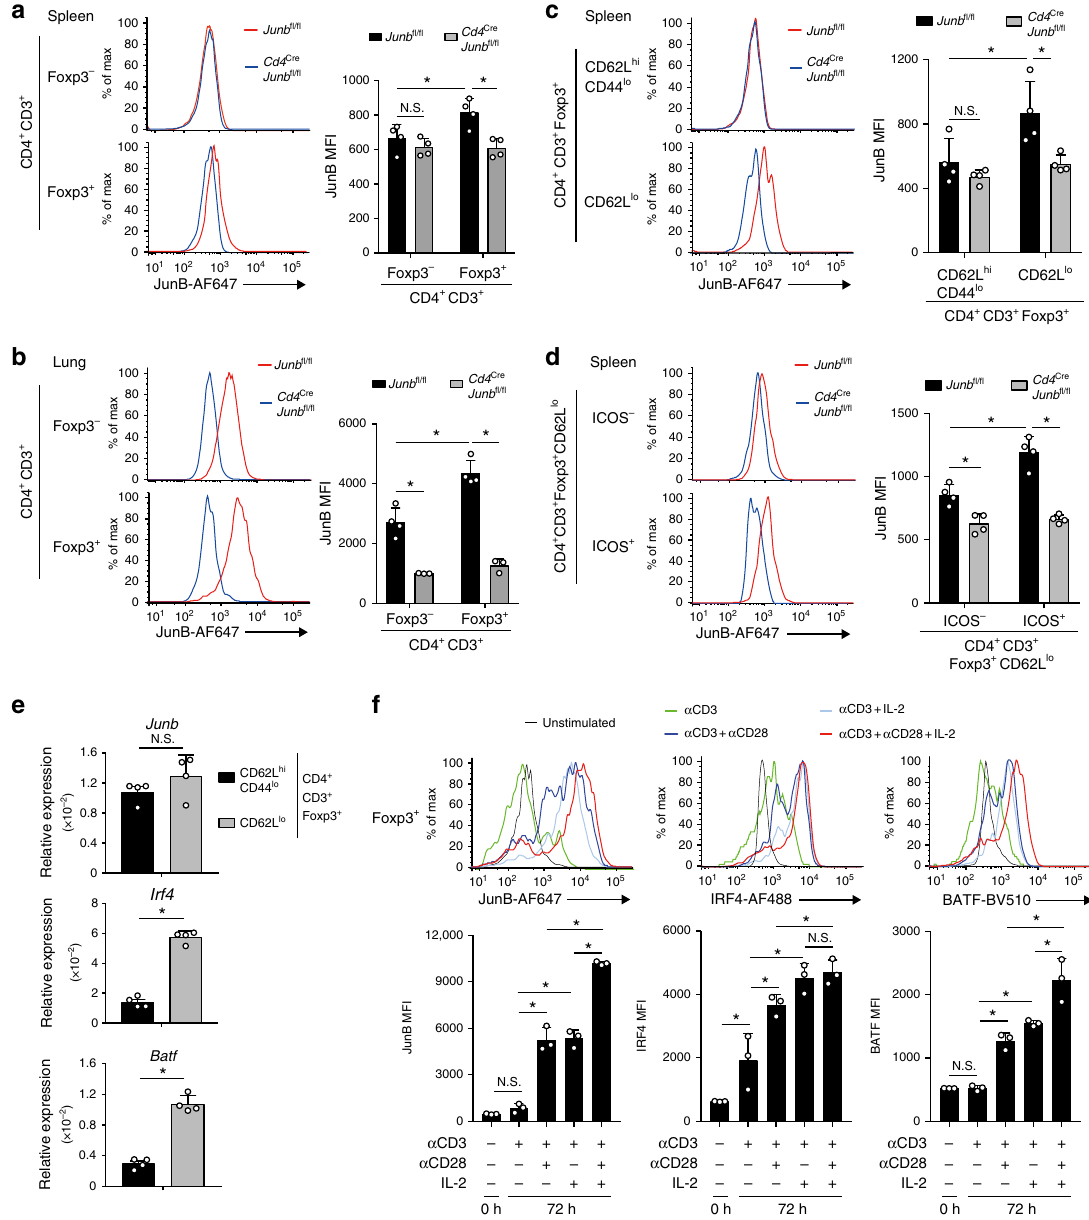
Fig. 1 Expression of JunB is upregulated in eTreg cells. a – d Flow cytometry analysis of JunB in Foxp3 + (Treg) or Foxp3 − (Tconv) cells isolated from spleen a and lung b , Treg cells bearing CD62L hi CD44 lo phenotypes (cTreg) or CD62L lo phenotypes (eTreg) c , and ICOS + or ICOS − eTreg cells d isolated from spleen of wild-type C57BL/6 mice (7 – 10-week-old). Cd4 cre Junb fl / fl mice were used as negative controls. e CD62L hi CD44 lo cTreg and CD62L lo eTreg cells were sorted by FACS, and Junb mRNA expression was analyzed by qRT-PCR. a – e Error bars indicate s.d. ( n = 4). * P < 0.05; N.S., not signi fi cant (unpaired two-tailed Student ’ s t test). MFI, mean fl uorescence intensity. f JunB expression was analyzed by fl ow cytometry in CD4 + CD25 + Treg cells activated with indicated stimuli for 72 h. Error bars indicate s.d. ( n = 3). * P < 0.05; N.S., not signi fi cant (unpaired two-tailed Student ’ s t test). Data represent